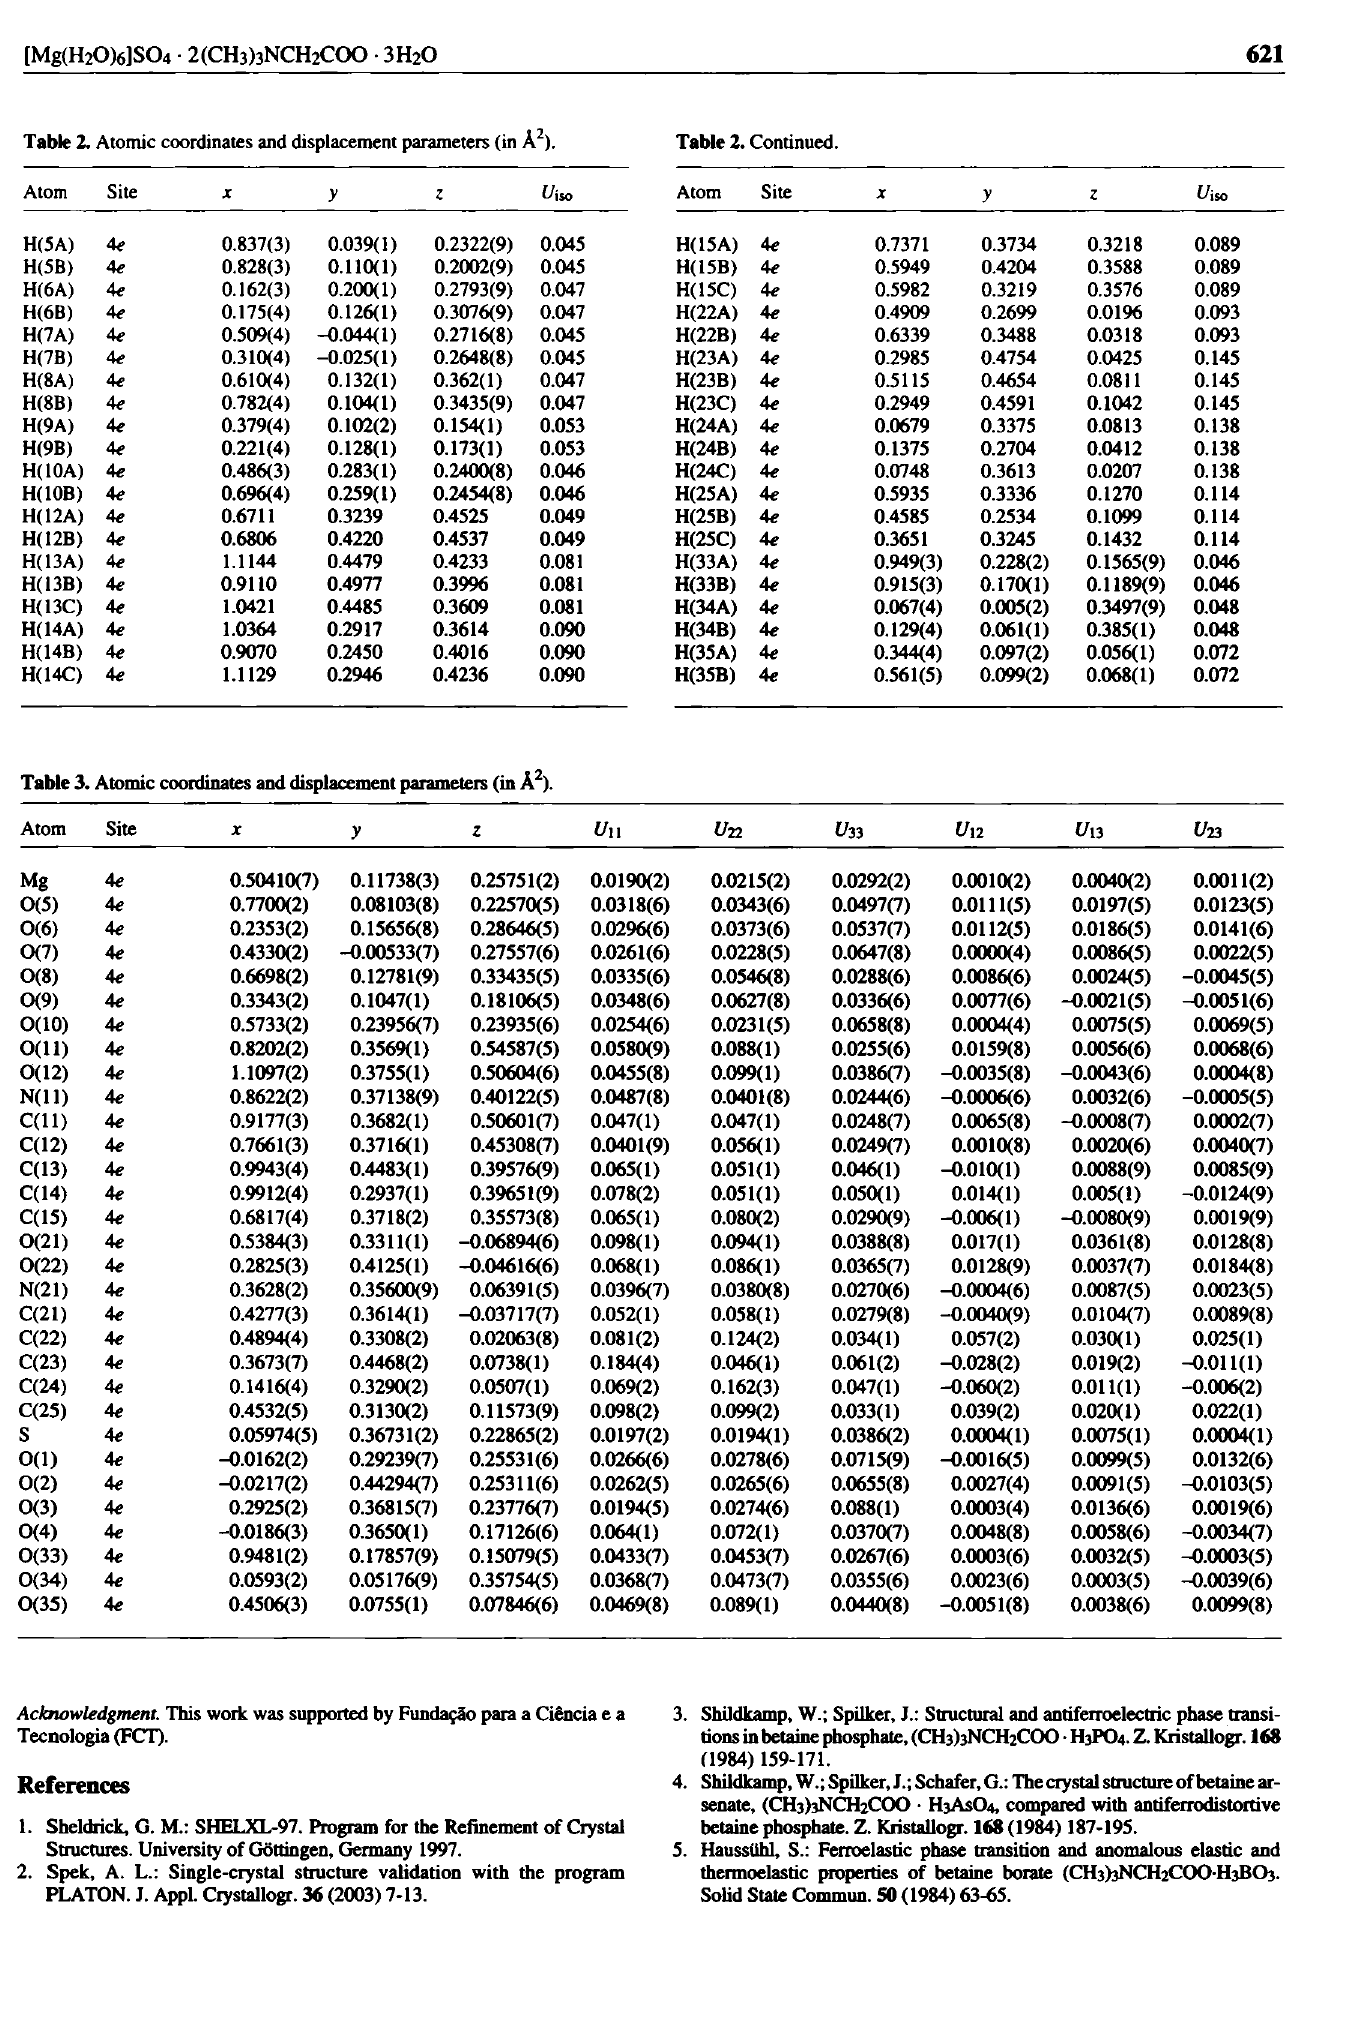
Table 2. Atomic coordinates and displacement parameters (in A 2 ).